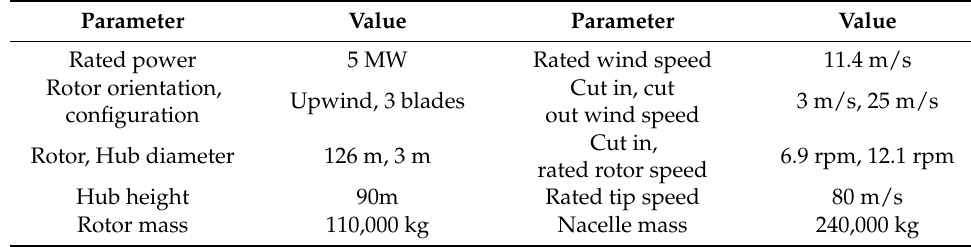
Table A1. Parameters of the 5 MW baseline wind turbine